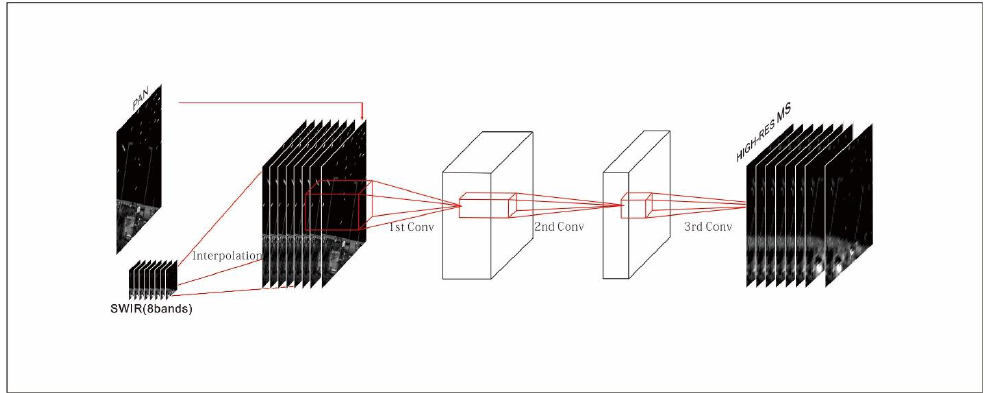
Figure 1. The CNN structure of for